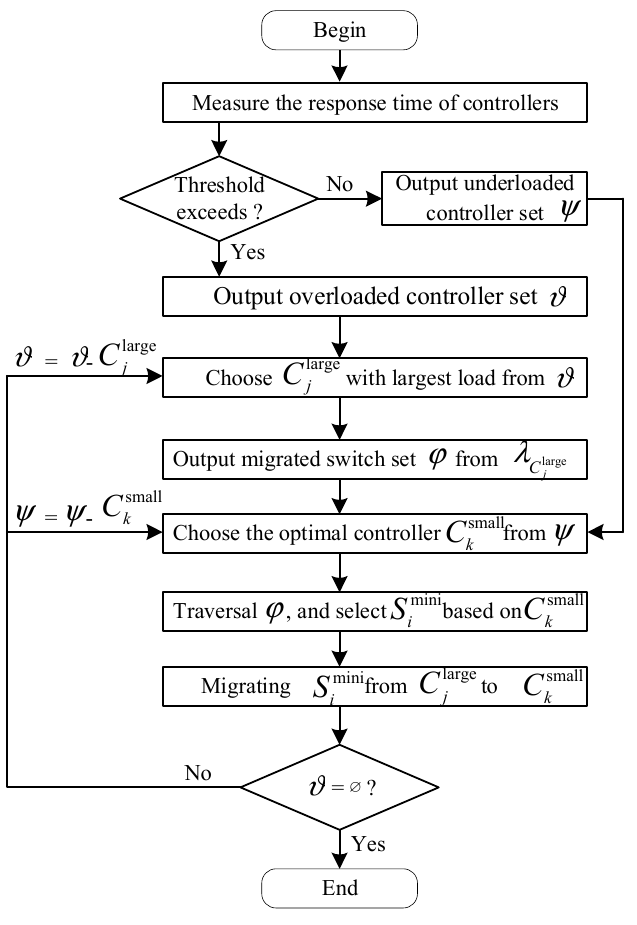
Figure 3. Flowchart of CASM framework.